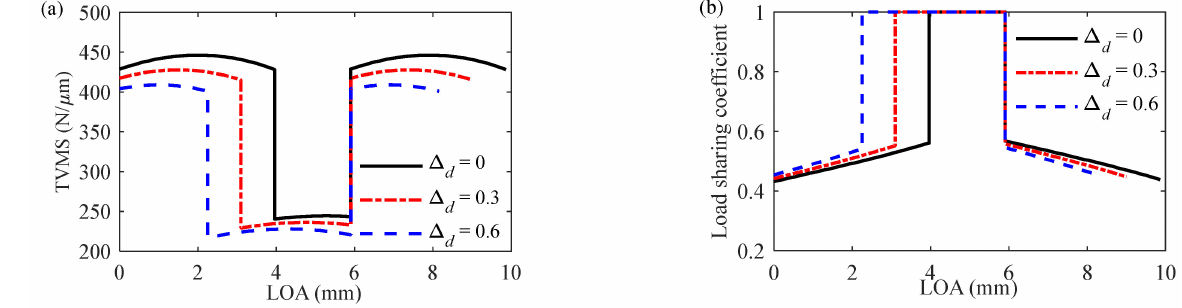
Figure 4. TVMS and Load sharing factor: ( a ) TVMS and ( b ) Load sharing coefficient.